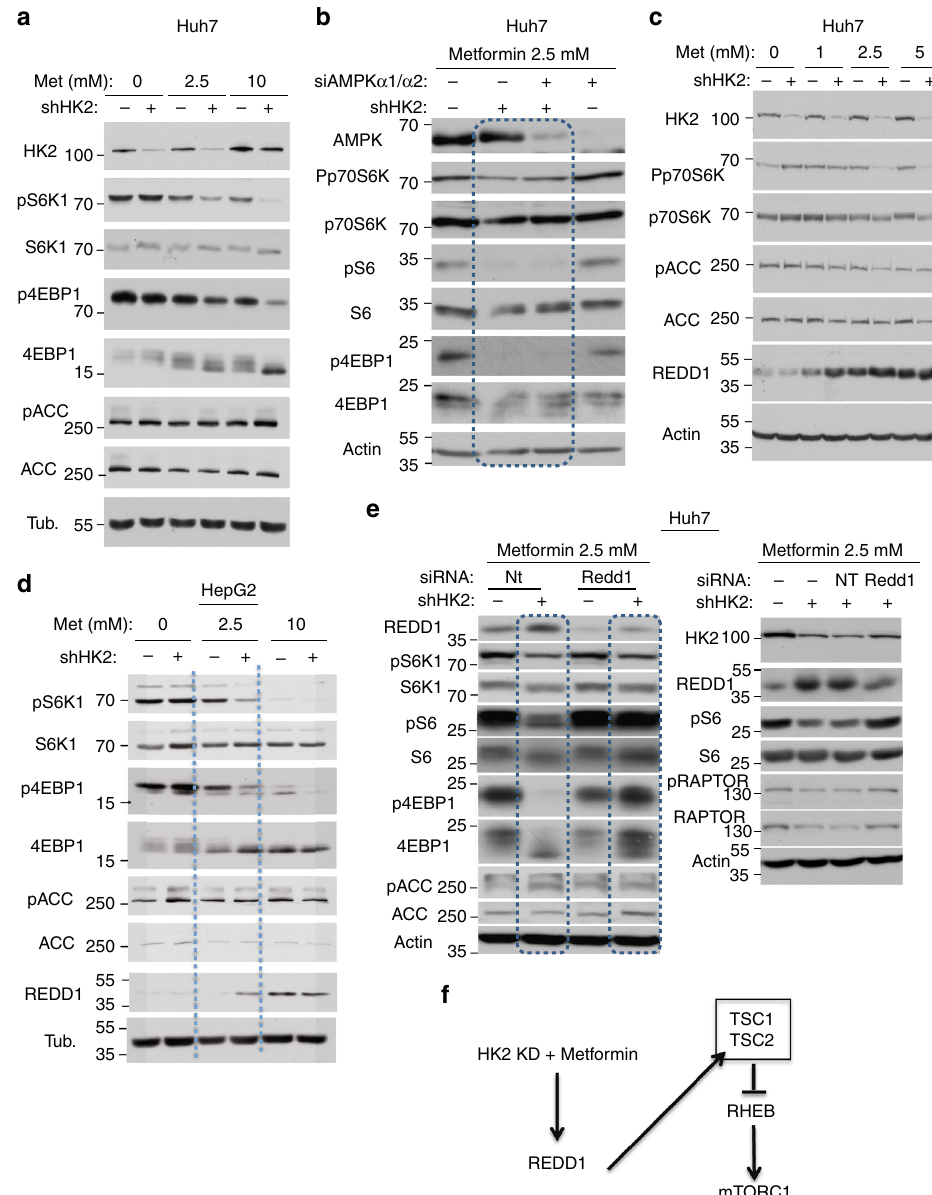
Fig. 7 Effect of HK2 KD and metformin on mTORC1 activity in HCC cells. Cells were exposed to Dox for three days and metformin for the last 24 h. a Immunoblot showing the effect of HK2 KD and metformin on mTORC1 activity as measured by the phosphorylation of S6K1 and 4EBP1 and on AMPK activity as measured by the phosphorylation of ACC, in Huh7 cells. b Immunoblot showing the effect HK KD and metformin on mTORC1 activity after the KD of AMPK α 1 and α 2. c Immunoblot showing the induction of REDD1 expression after HK2 KD and metformin Huh7 cells. d Immunoblot showing the induction of REDD1 expression after HK2 KD and metformin HepG2 cells. e The effect of REDD1 KD on mTORC1 activity after HK2 KD and metformin as measured by S6K1 and 4EBP1 phosphorylation or S6 phosphorylation. AMPK kinase activity was evaluated by ACC phosphorylation (left panel) and by Raptor phosphorylation (right panel). Immunoblot images are representative of at least two independent experiments. f Schematic showing the mechanism by which the combination of HK2 KD and metformin inhibits